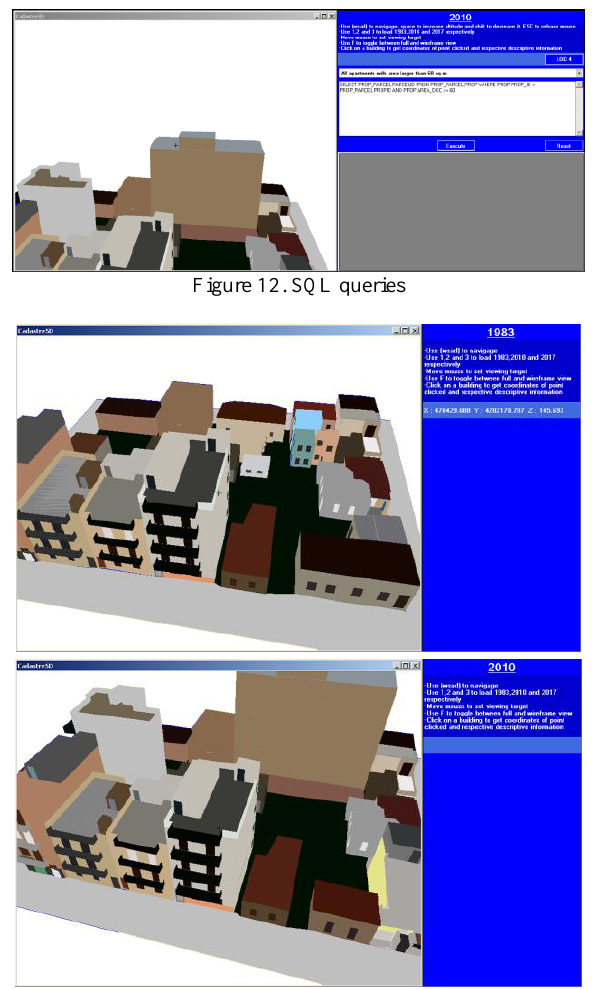
Figure 13. 3D view of the building models at LoD2 in the year 1983 (top) and 2010 (bottom)